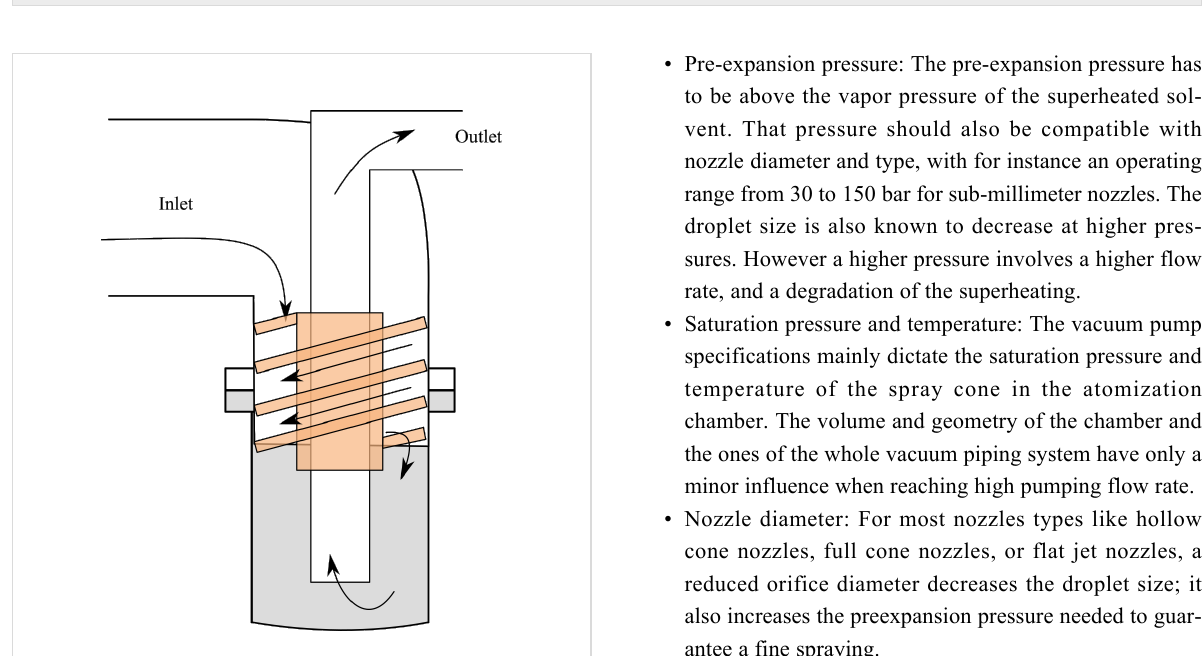
Figure 4: Schematic cross-sections of the nozzle and its heating system; from left to right, rear view, longitudinal cross-section and front view.